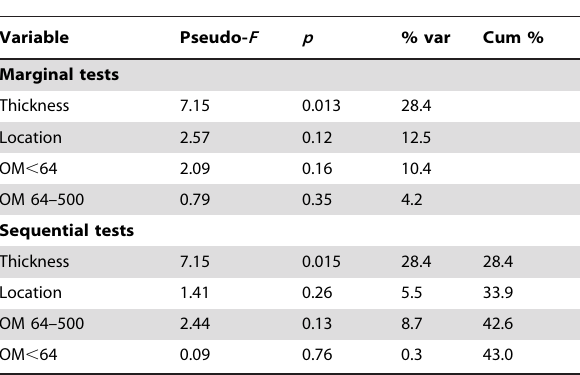
Table 3. DISTLM of the densities of Cirolana harfordi in oyster-beds, using Thickness of the habitat, Concentration of organic matter smaller than 64 m m (OM , 64), Concentration of organic matter between 64 and 500 m m (OM 64–500) and Location as predictor variables. For marginal tests, variables are taken individually; for sequential tests, variables were chosen using Forward selection criteria. The column %var indicates the percentage of the variation explained by the predictor variables. Cum % is the cumulative percentage of variance